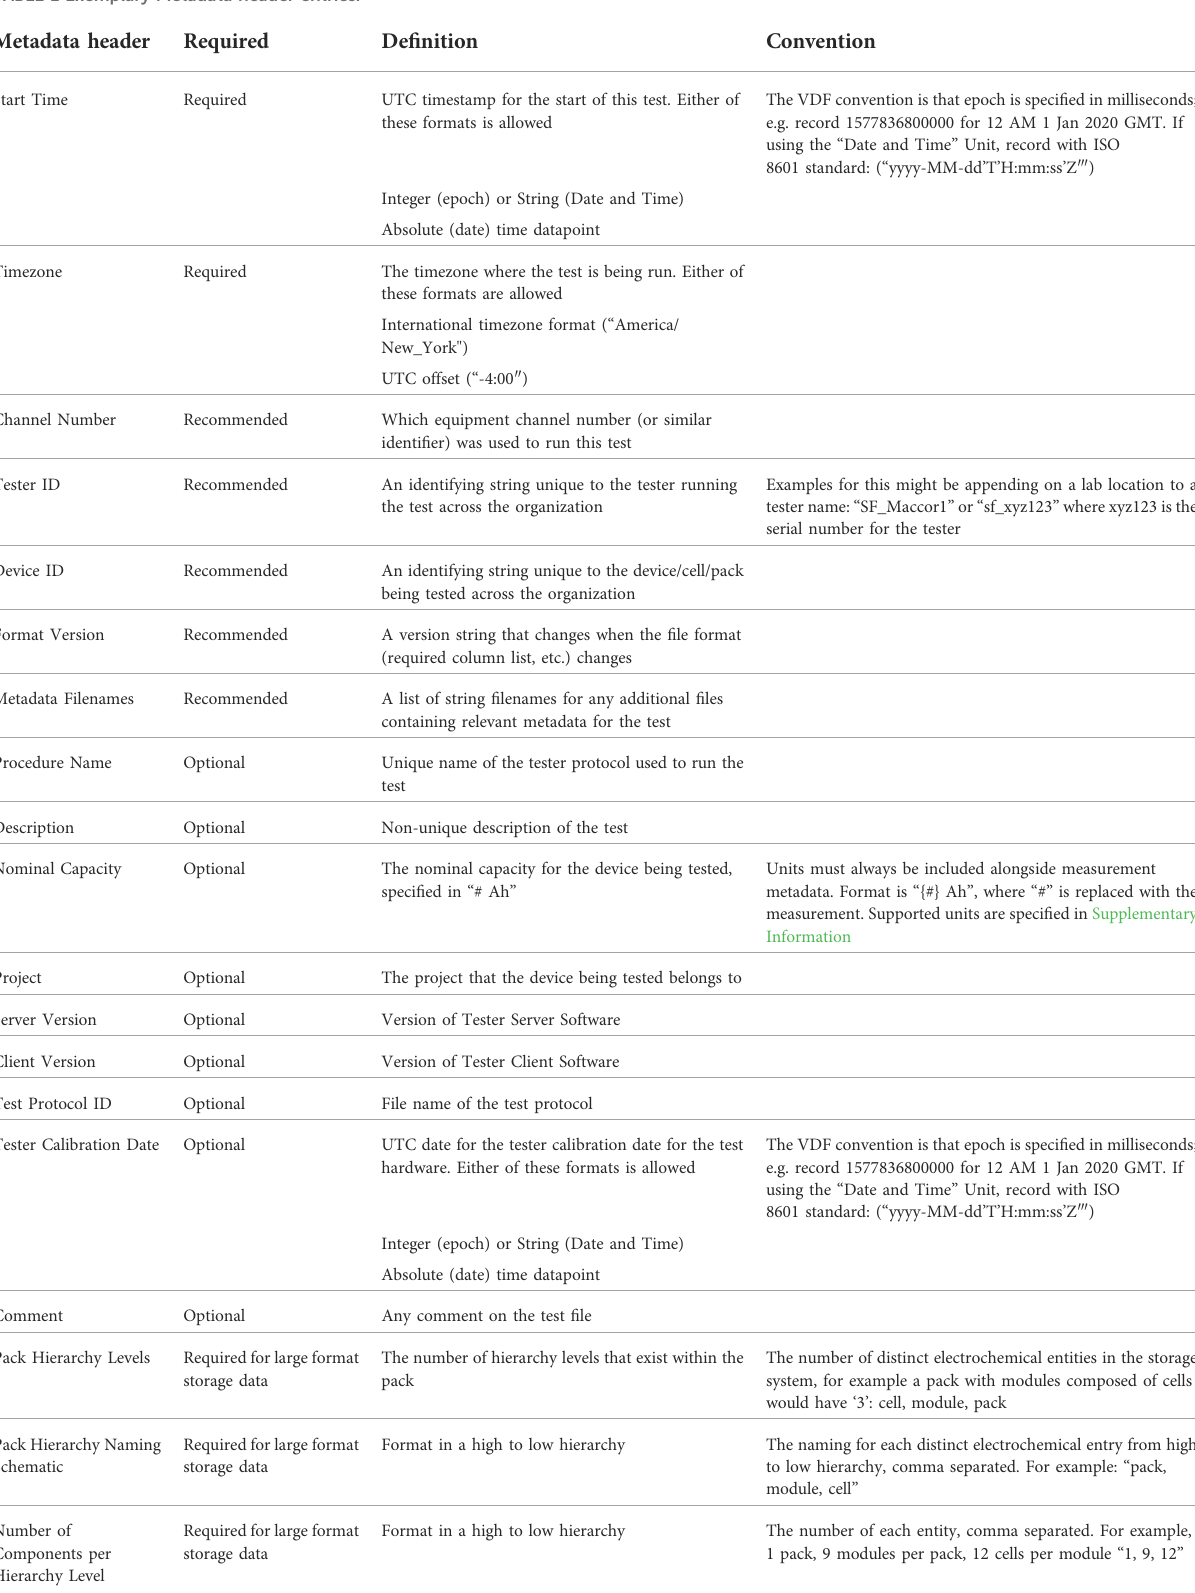
TABLE 1 Exemplary Metadata header